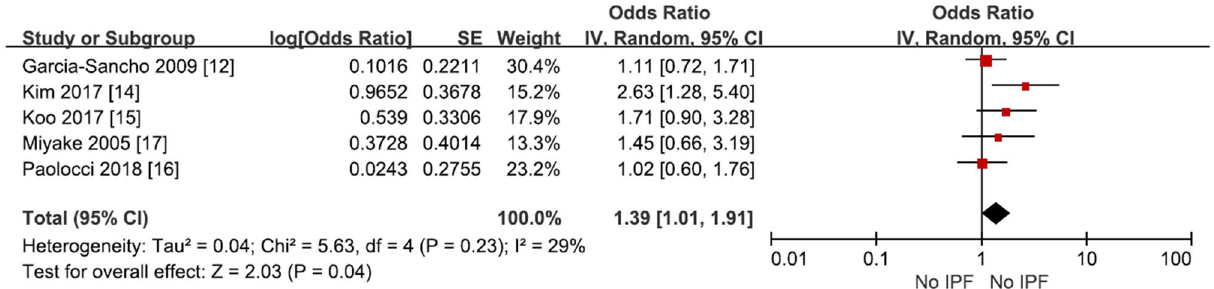
Figure 4. Risk of IPF in ever smoker compared with never